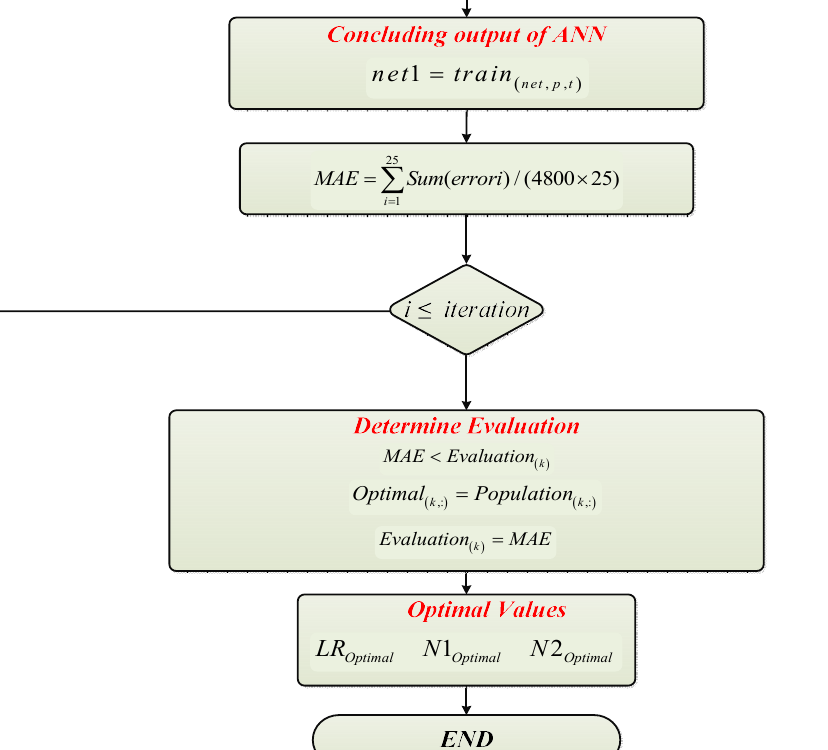
Figure 7. General flow chart of optimization algorithms for ANN-PSO, ANN-GA, ANN-ABC, and ANN-BSA for 100 iteration.